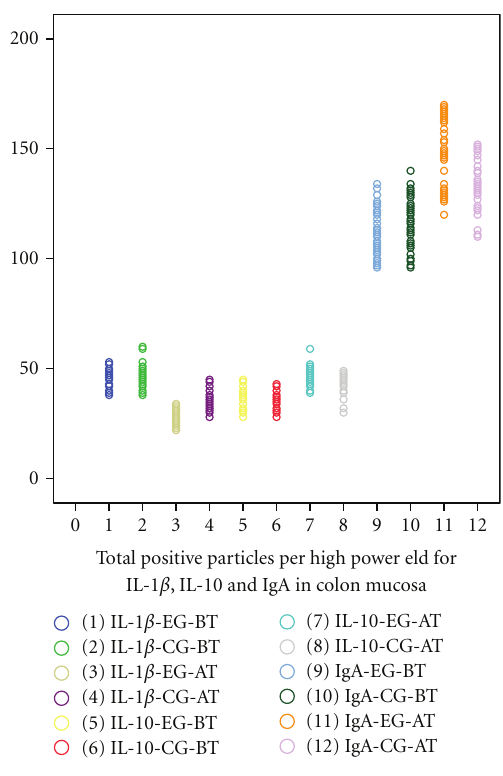
Figure 2: EG stands for experiment group; CG stands for control group; BT stands for “before treatment”. AT stands for “after treatment”. The average number of positive immunoreactivity particles for IgA, IL-1 β , or IL-10 in colon mucosa was no significant di ff erence before treatment between two groups. Two months after treatment, the average number of positive particles for IgA and IL- 10 in colon mucosa in each group increased significantly ( P < 0 . 01).